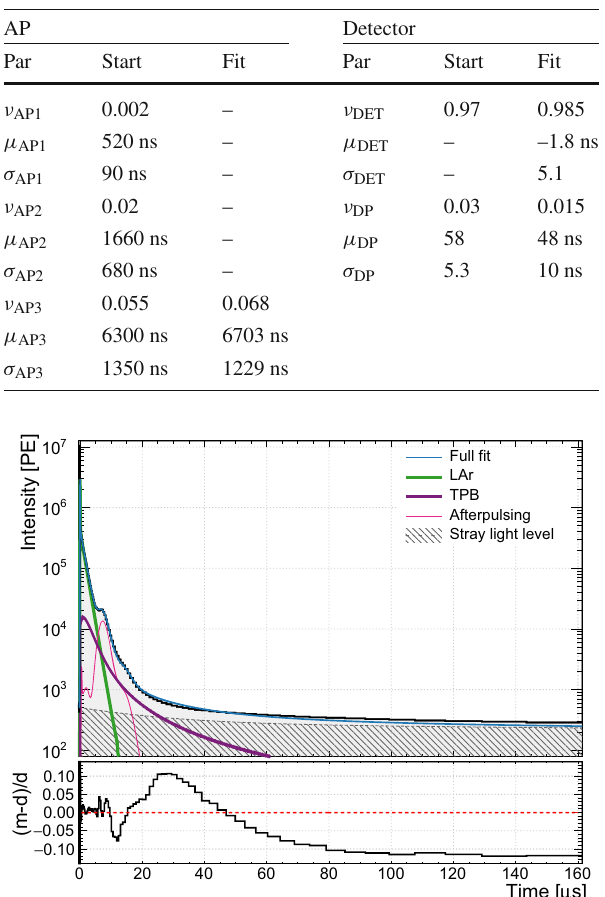
Table2 Startandfitparameters,instrumentaleffects.Parameteruncer- tainties are not given, as explained in the text